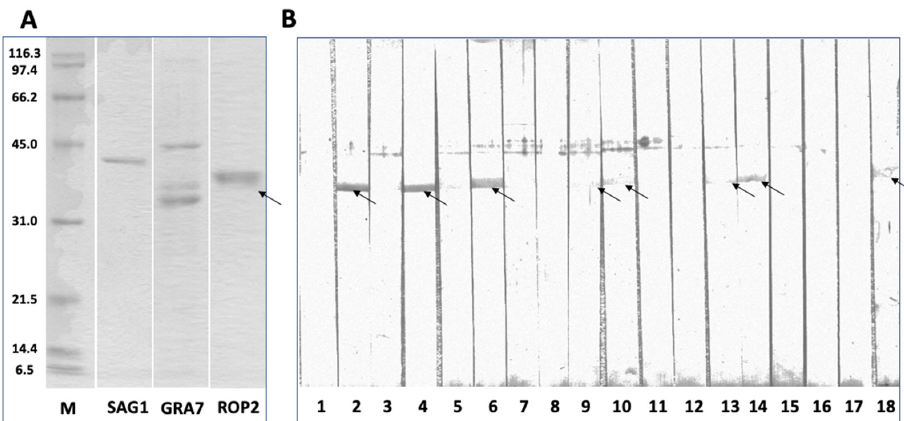
Figure 6. SDS-PAGE of recombinant antigens used for ELISA and Western blot showing the reactivity with recombinant NcROP2 of individual mouse sera from mice vaccinated with the triple mutant Lm3Dx_NcSAG1_NcGRA7_NcROP2. ( A ): the individual recombinant antigens NcSAG1, NcGRA7 and NcROP2 obtained after Ni 2+ affinity chromatography are shown; M indicates the molecular weights of separated proteins. ( B ): Western blot of recombinant NcROP2. Lane 1 shows a negative control serum; lane 2 a positive control serum; sera in lanes 3–18 are from animals that were vaccinated with the triple mutant and challenged with N. caninum tachyzoites; lanes 3–8 are sera from non- pregnant mice; and 9–18 are sera from